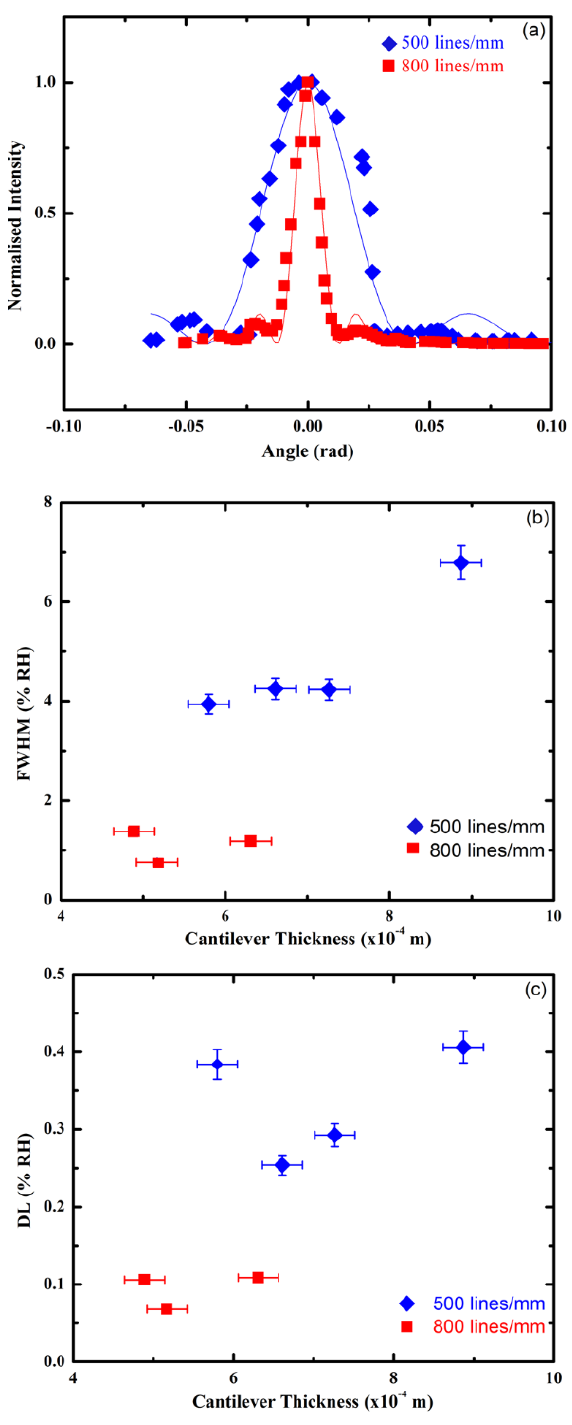
Figure 3. ( a ) Typical Bragg selectivity curves for two samples with a similar thickness (637 µm and 634 µm) and different gratings (800 and 500 lines/mm, respectively). The intensities are normalized in order to allow direct comparison between samples. The fitting was performed using the diffraction efficiency equation (Equation (1)); ( b ) FWHM; and ( c ) the detection limit variation for a cantilever with thickness for a different diffraction grating.